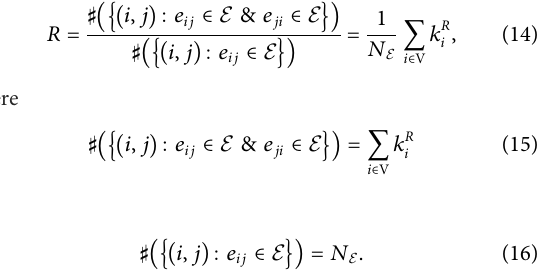
EvolutionofoverallreciprocityofthefouriCTNsfrom1993to 2018. The overall reciprocity coef fi cients were between 0.1 and